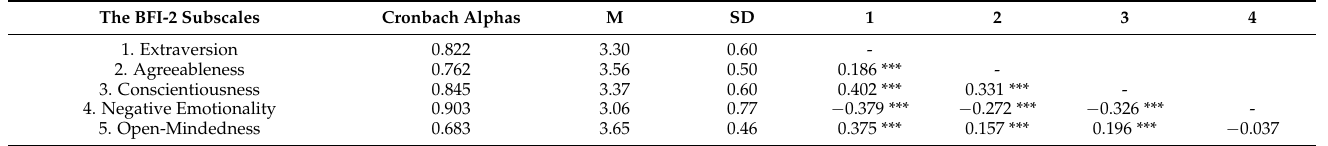
Table 2. The BFI-2: descriptive statistics and correlations between the subscales. The BFI-2